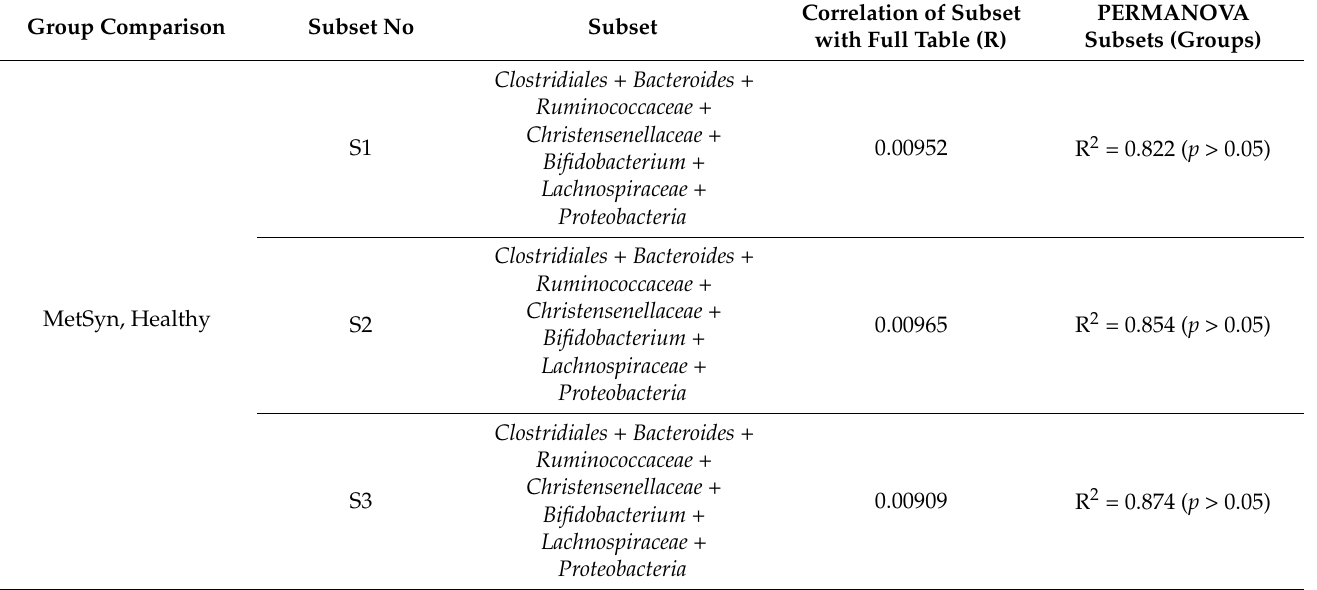
Table 3. Subset analysis for MetSyn vs. control patients displaying subsets of OTUs along with the correlation of the beta diversity distances between these subsets and the full OTU table. The last column shows PERMANOVA statistics for these subsets pointing out their discriminatory power. R 2 represents the percentage variability of these subsets in terms of